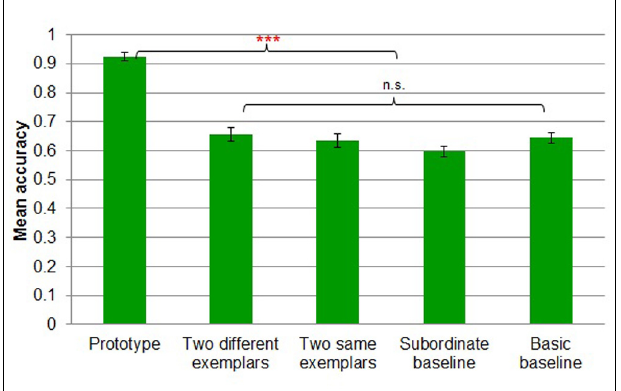
FIGURE 9 | Mean accuracy by study condition in Experiment 3. Error bars represent SEs. *** p < 0.001.